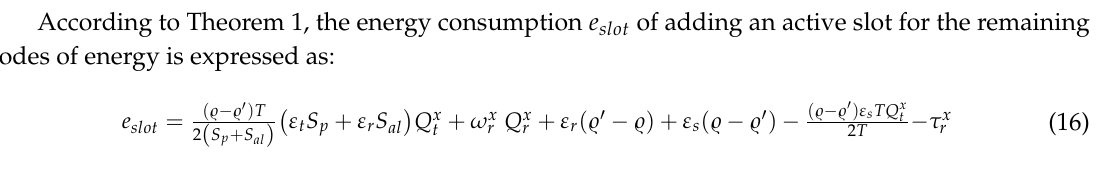
Figure 11. Node that can add a time slot and is closest to the sink.